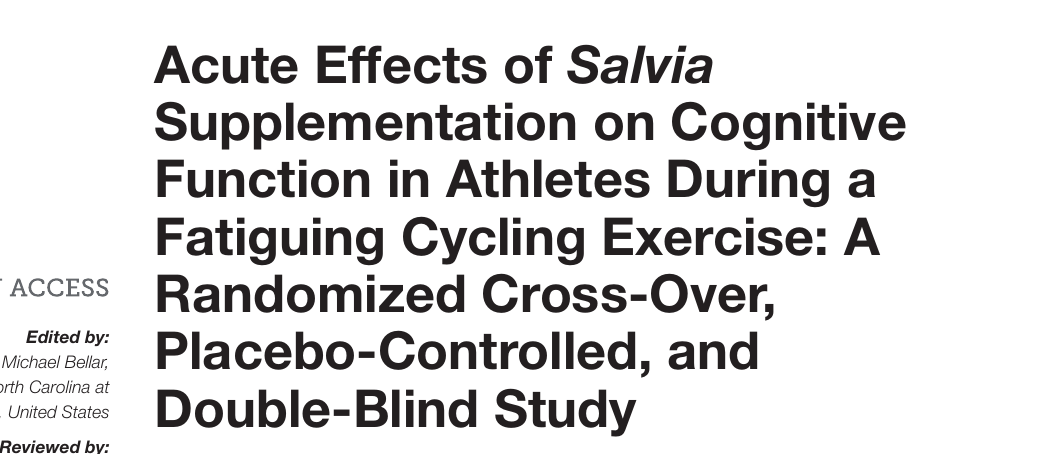
Cross-Over, Placebo-Controlled, and Double-Blind